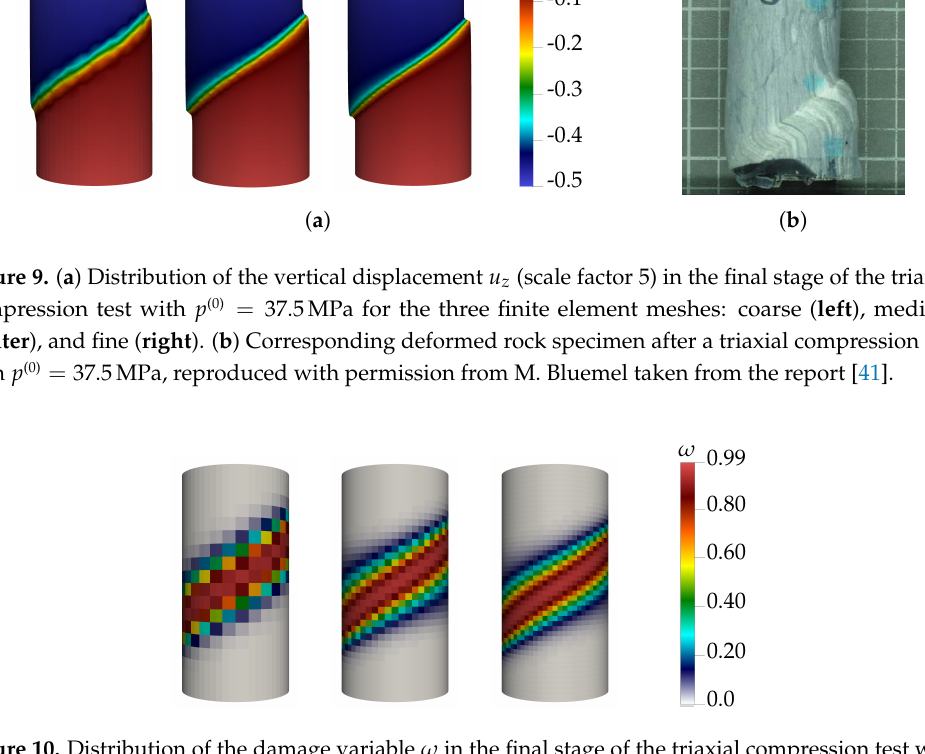
Figure 10. Distribution of the damage variable ω in the final stage of the triaxial compression test with p (0) = 37.5MPa for the three finite element meshes: coarse ( left ), medium ( center ), and fine ( right